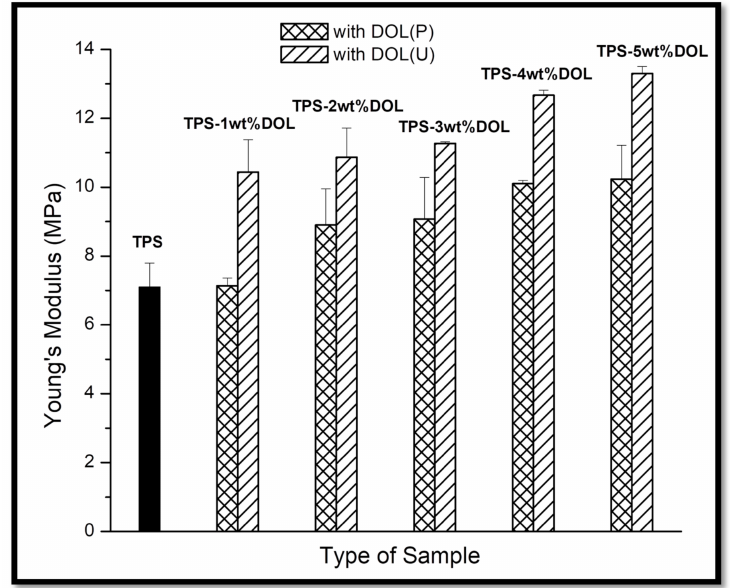
Figure 12. Young’s modulus of TPS film and TPS-DOL biocomposite